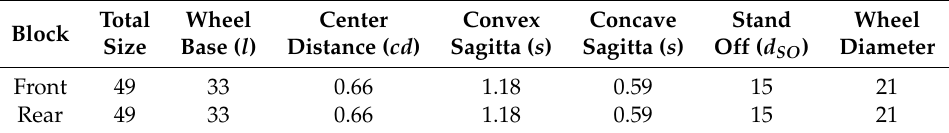
Table 2. Parameters and dimension values of our sensor carrier. All parameters are expressed in